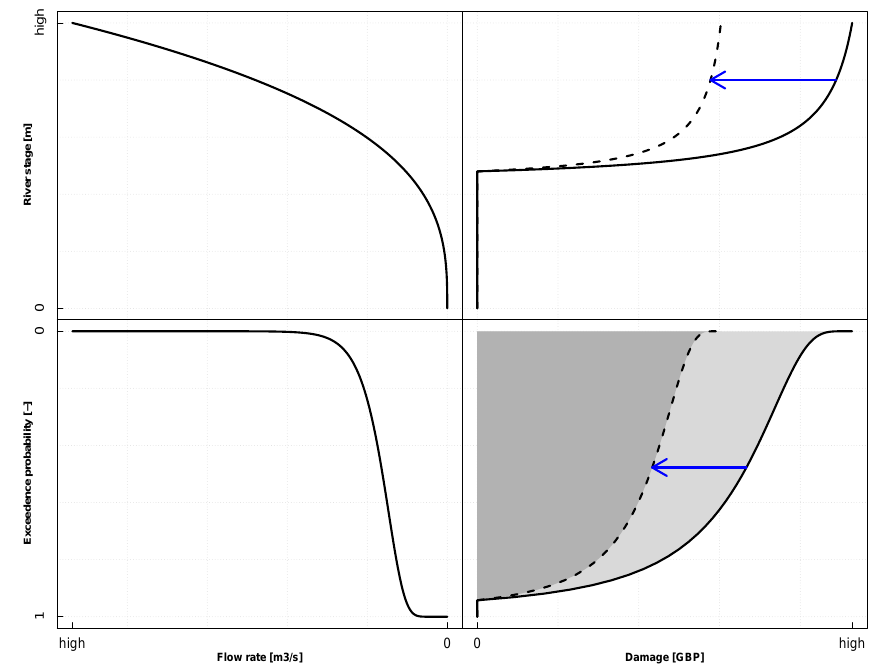
Fig. 2. Schematic representation of the hydro-economic EAD-model. The bottom left panel shows the probability distribution of flow rates. The stage-discharge relationship is shown in the top left panel, and flood damage curve in the top-right quadrant. These three relationships yield the damage-probability curve (bottom right panel). The figure shows how a flood risk management measure affects flood risk, with the ex-ante situation as a solid, and the ex-post as a dotted